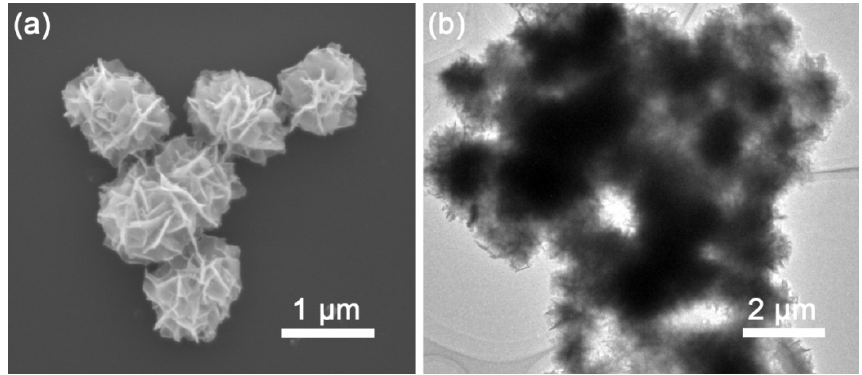
Figure 2. ( a ) SEM and ( b ) TEM images of the pristine CTS.